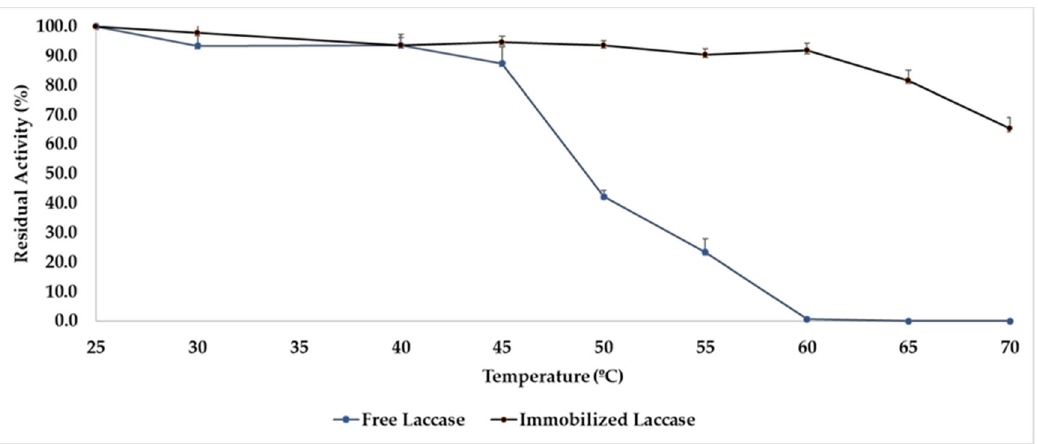
Figure 6. Thermal stability of free and immobilized L Asp in function of residual activity. Conditions: 10 mg of biocatalyst or 10 uL of free laccase in 1 mL of phosphate buffer at pH 7.0 (0.05 mol.L − 1 ) in cryotubes under stirring in a shaker at 120 rpm in temperatures ranging from 25– 70 ° C .